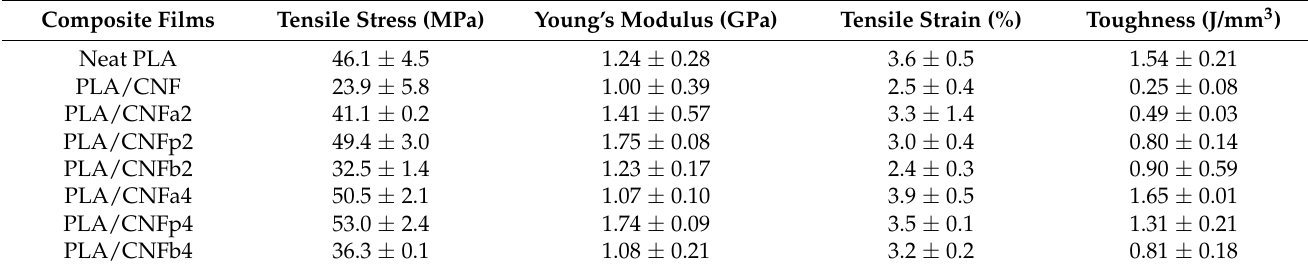
Table 4. Average tensile strength, Young’s modulus, tensile strain, and toughness of the PLA/m-CNF composite films. Composite Films